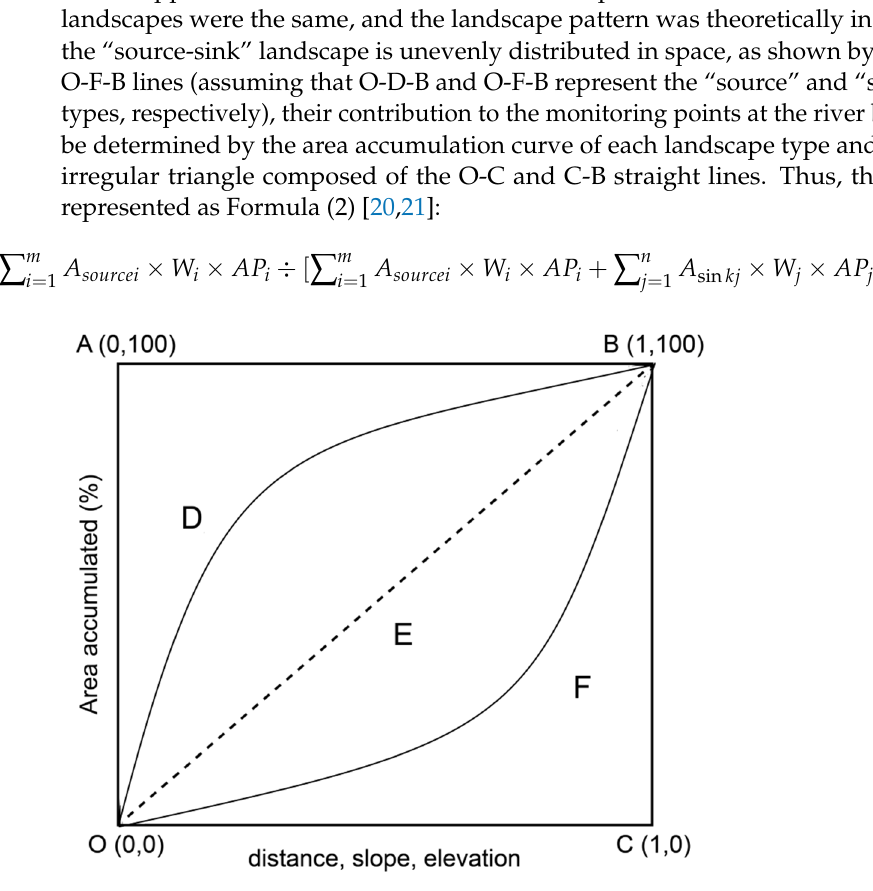
Figure 4. Distribution of “source” and “sink” landscape types. Adapted from [21].